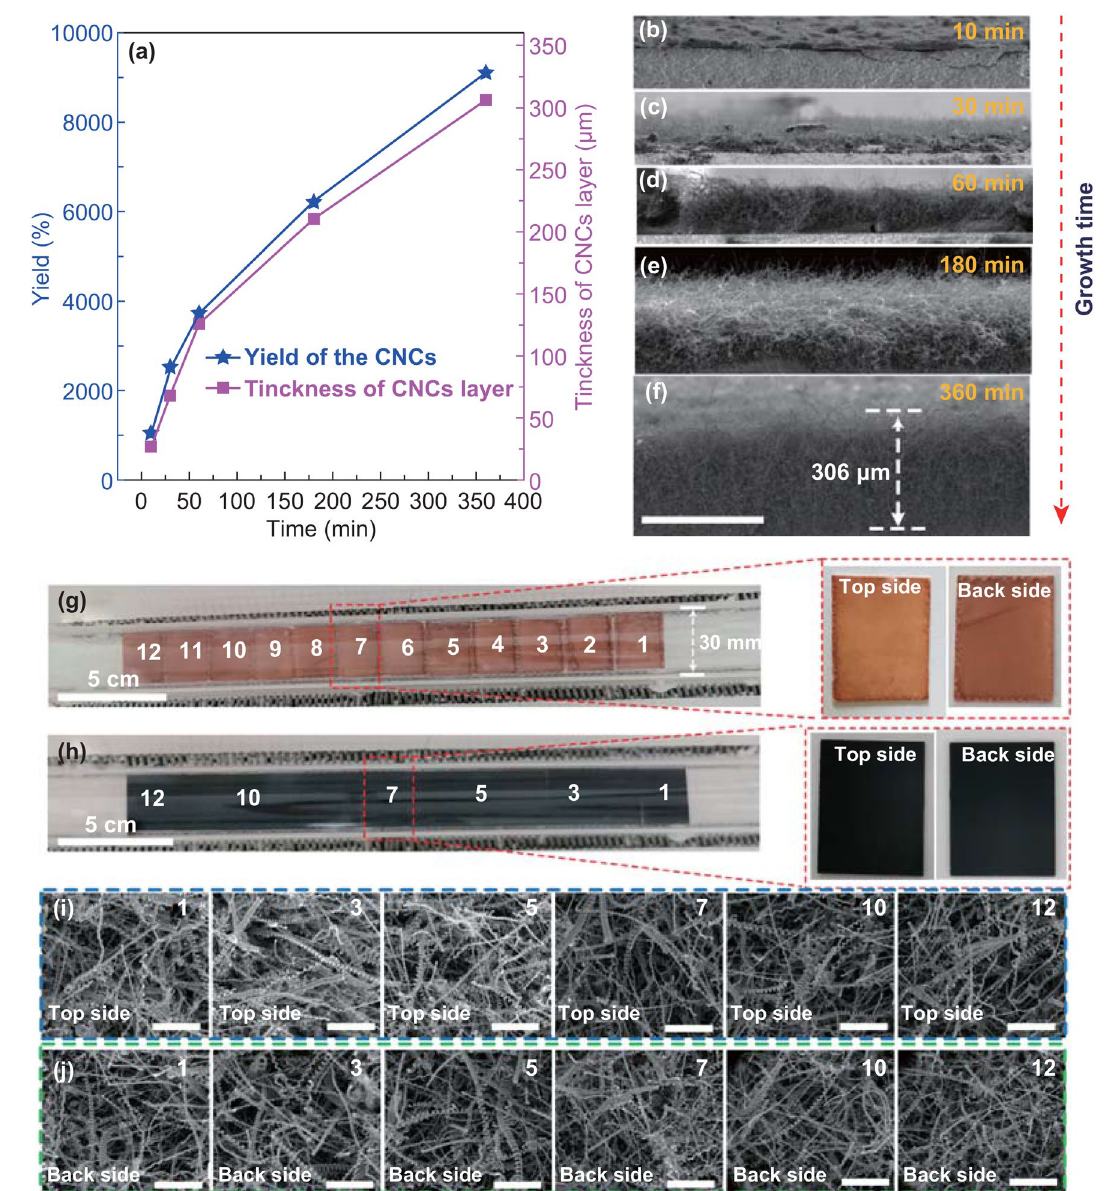
Fig. 4 a Plots of yield and thickness of CNCs versus growth time; cross-sectional SEM images of CNCs grown for b 10, c 30, d 60, e 180, and f 360 min. Optical photographs of the substrates g before and h after the ‘scale-up’ CVD reaction. The scale bar for b–f is 300 μm. i, j Top and back sides SEM images of the carbon deposits prepared with different substrates of 1, 3, 5, 7, 10, and 12. The scale bar for i and j is 5